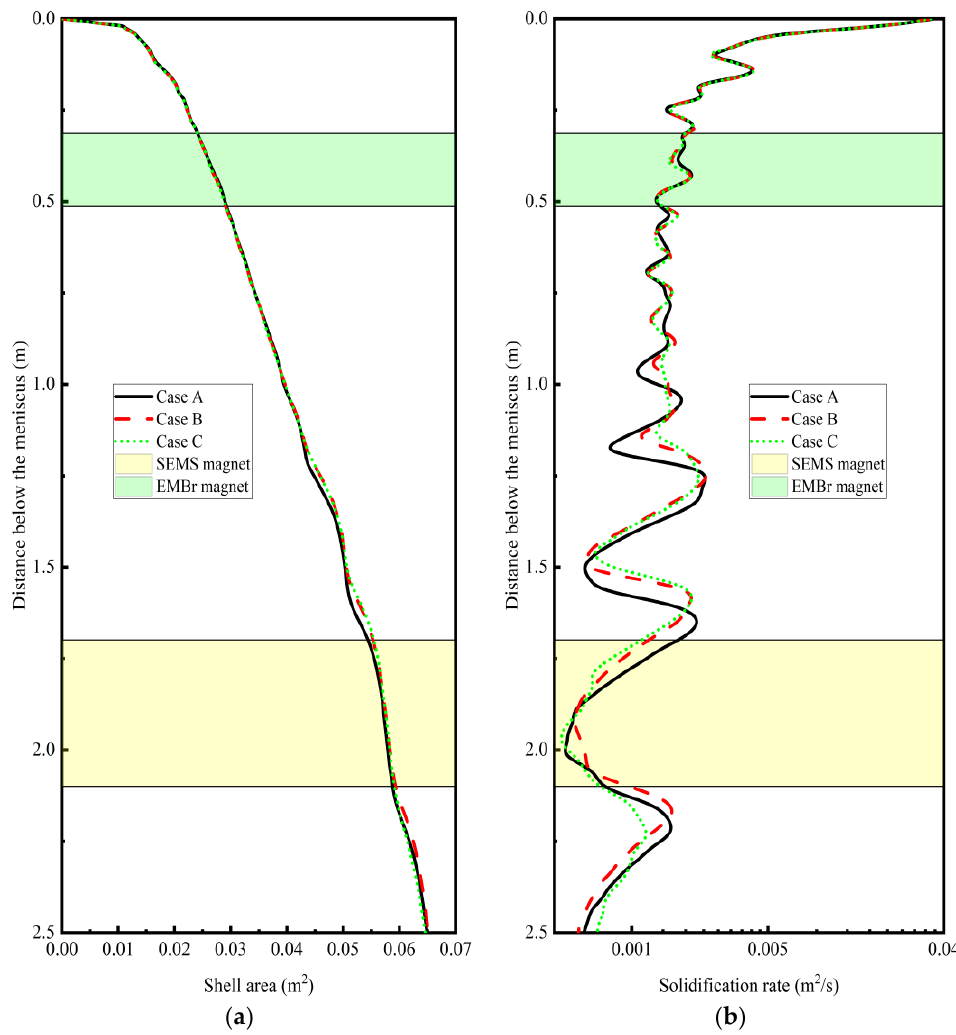
Figure 16. The ( a ) solidified shell area and ( b ) solidification rate with the distance below the me- niscus.